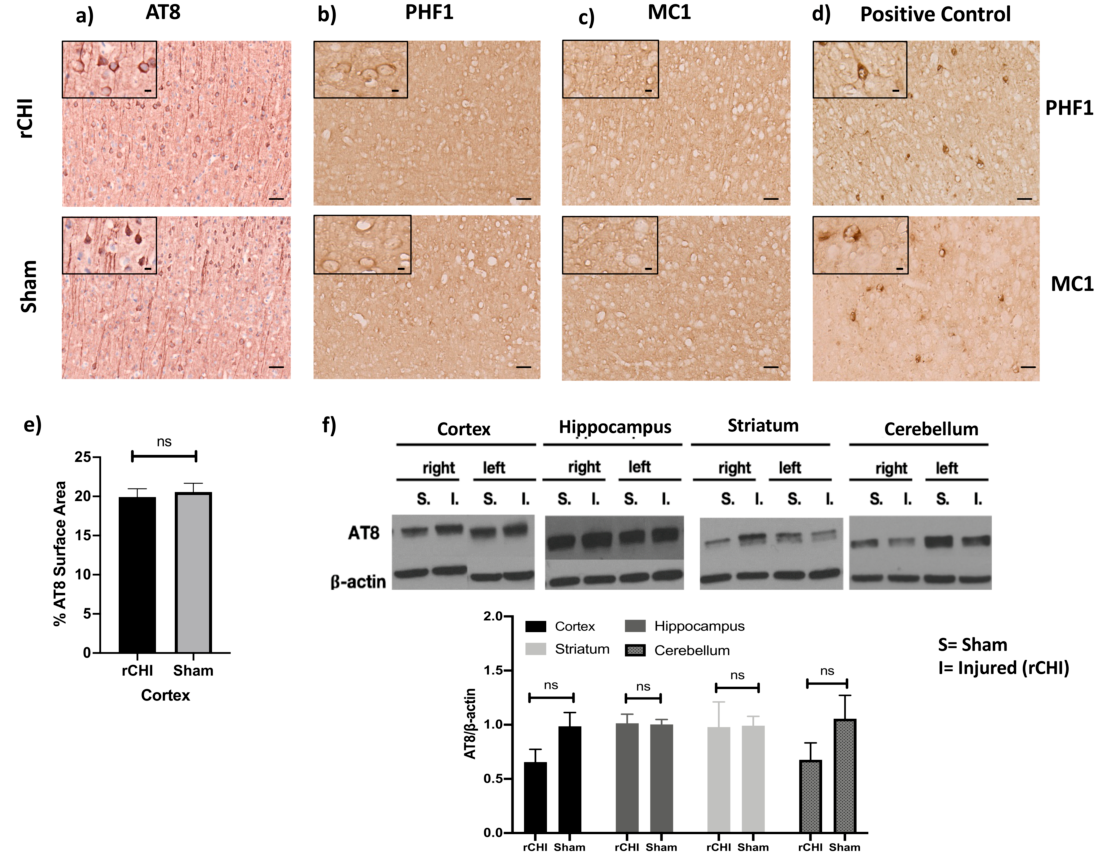
Figure 1. Repetitive closed-head injury (rCHI) did not alter tau pathology in adolescent P301S mice 40 days post-injury. Representative immunohistochemistry (IHC) of ( a ) AT-8 which shows no increase in tau phosphorylation in cortical neuronal cell bodies in rCHI vs. sham P301S mice at 40 days post-injury. ( b , c ) Representative IHC of ( b ) PHF1, ( c ) MCI of the cortex of P301S rCHI and sham mice show a paucity of tau staining with only a few cortical neuronal cell bodies in both sham and injured P301S mice at 40 days post-injury. ( d ) widespread tau staining (both PHF1and MC1) in 270-day old naïve P301S mice. ( e ) Bar graphs show that no significant difference in cortical AT-8 surface area between rCHI and sham P301S mice ( n = 4/group, p = 0.67). ( f ) Bar graphs show that no change in AT-8 in brain homogenates of P301S at 40 days after rCHI vs. sham across all groups ( n = 5/group, p = 0.09 for cortex, p = 0.91 for hippocampus, p = 0.96 for striatum, p = 0.91 for cerebellum). Nonspecific Western blot bands were cropped for clarity in panels. Statistical significance is denoted as follows: ns (non-significant) p > 0.05. Scale bars are 50 μ m, and 10 μ m for photomicrographs on increasing magnification.